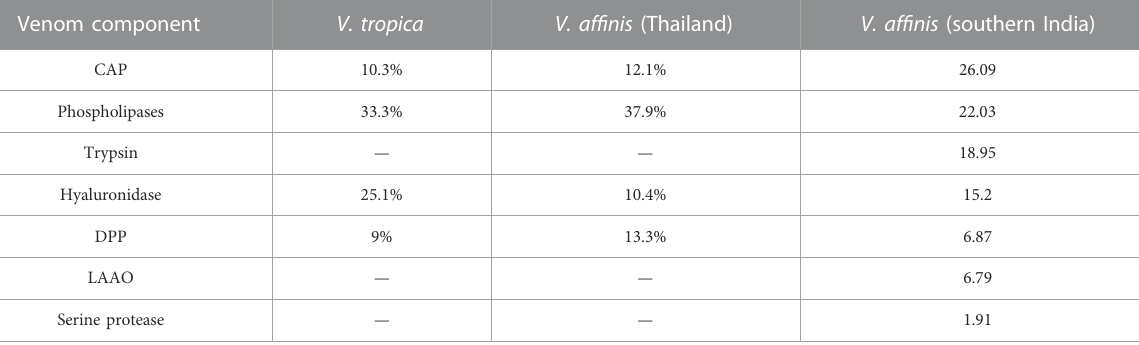
TABLE 2 Comparative proteomes of Vespa venoms. Venom